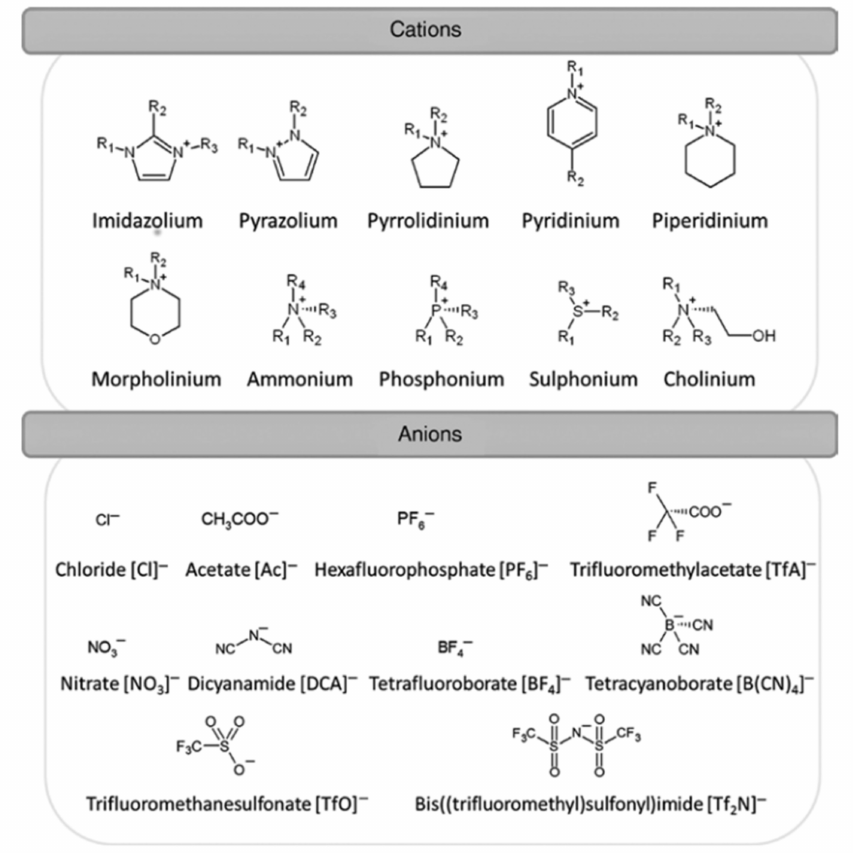
Figure 7. Chemical structure of the most common cations and anions widely used for ionic liquid compounds [93,94].